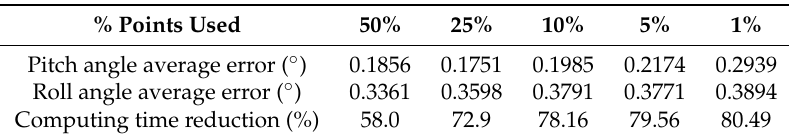
Table 1. Quantitative analysis of the error obtained in the estimation of the pitch ( θ ) and roll ( ρ ) angles for different numbers of road points